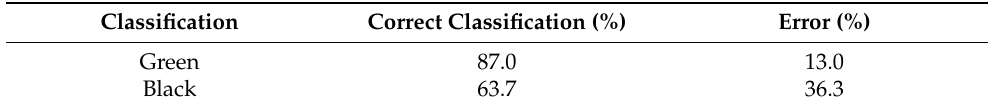
Table 3. Error rate in olive